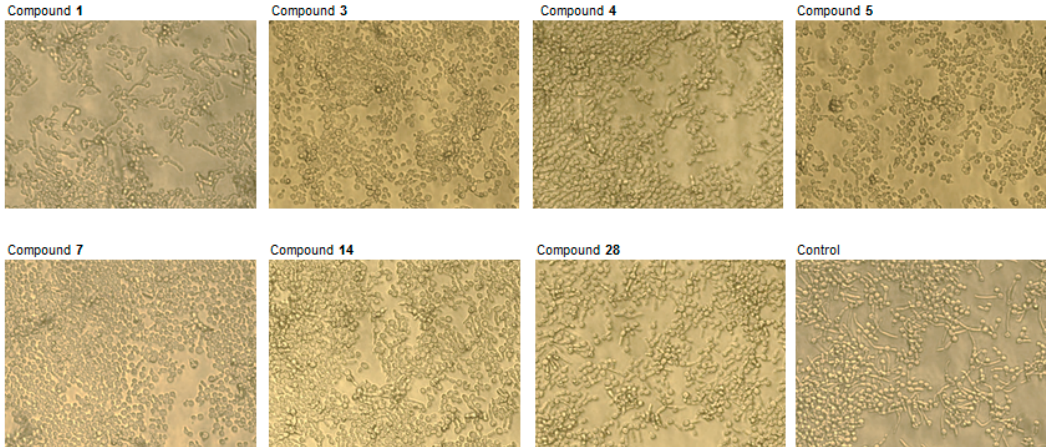
Figure 3. Structural framework of C. albicans ATCC 10231 grown for 2 h in RPMI1640-FCS culture medium containing chalcones at IC 50 values. Visual differences in cell morphotypes can be observed among the positive untreated control and cells at the different experimental conditions. DMSO was used at 0.5% as the solvent control and it did not affect hyphal transition.